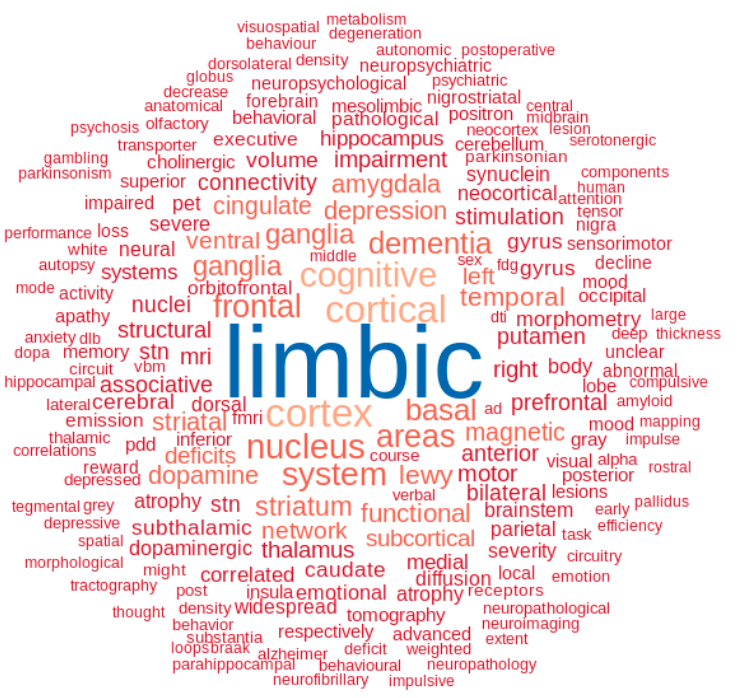
Figure 3. A cloud of the limbic system. The 200 most discriminant words characterizing the abstracts containing the word ‘limbic’ are depicted in the wordcloud. This illustrates the network organiza- tion of the limbic system, involving the frontal and cingular cortico-striatal system, its modulation by dopaminergic, serotonergic, noradrenergic and cholinergic projections from brainstem and fore- brain nuclei, and highlights the critical role of the limbic system in dementia, depression, apathy and impulse control